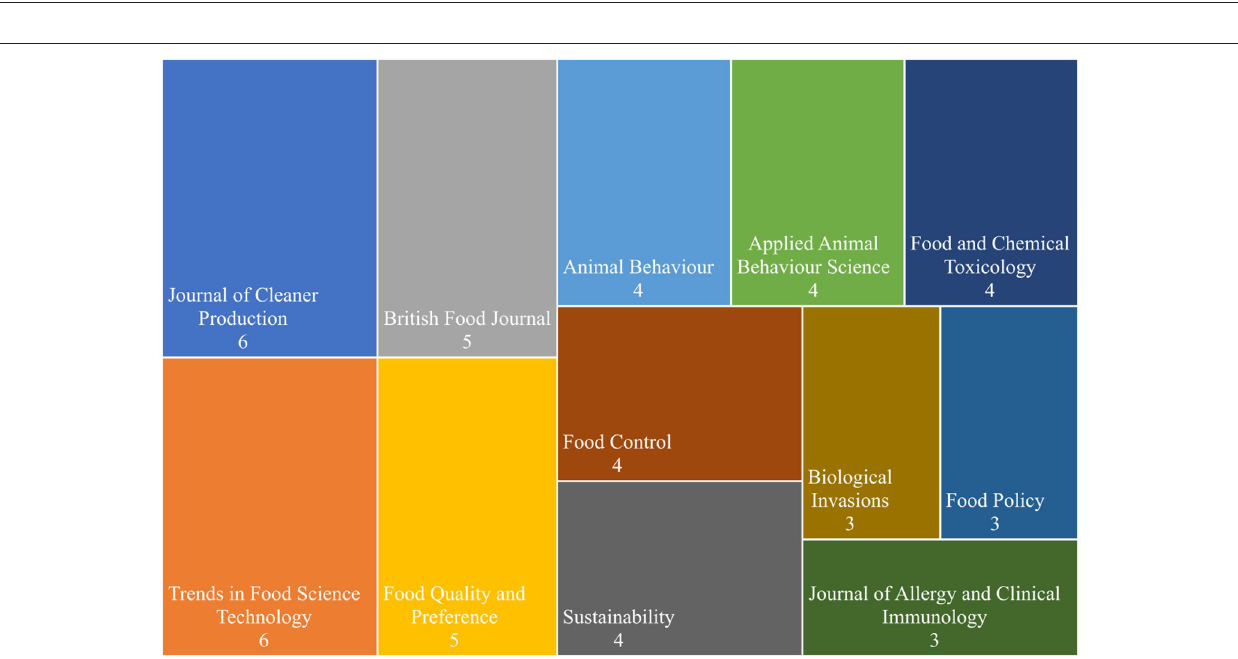
FIGURE 5 | Top Journals where the selected studies were conducted (Source: our